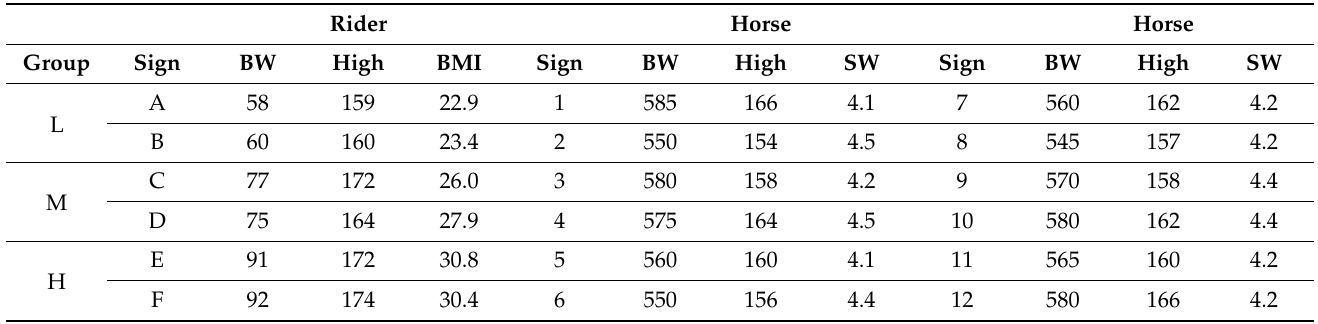
Table 1. Details of six riders (A–F), representing light (L), moderate (M), and heavy (H) groups, and twelve horses (1–12) that participated in the study.